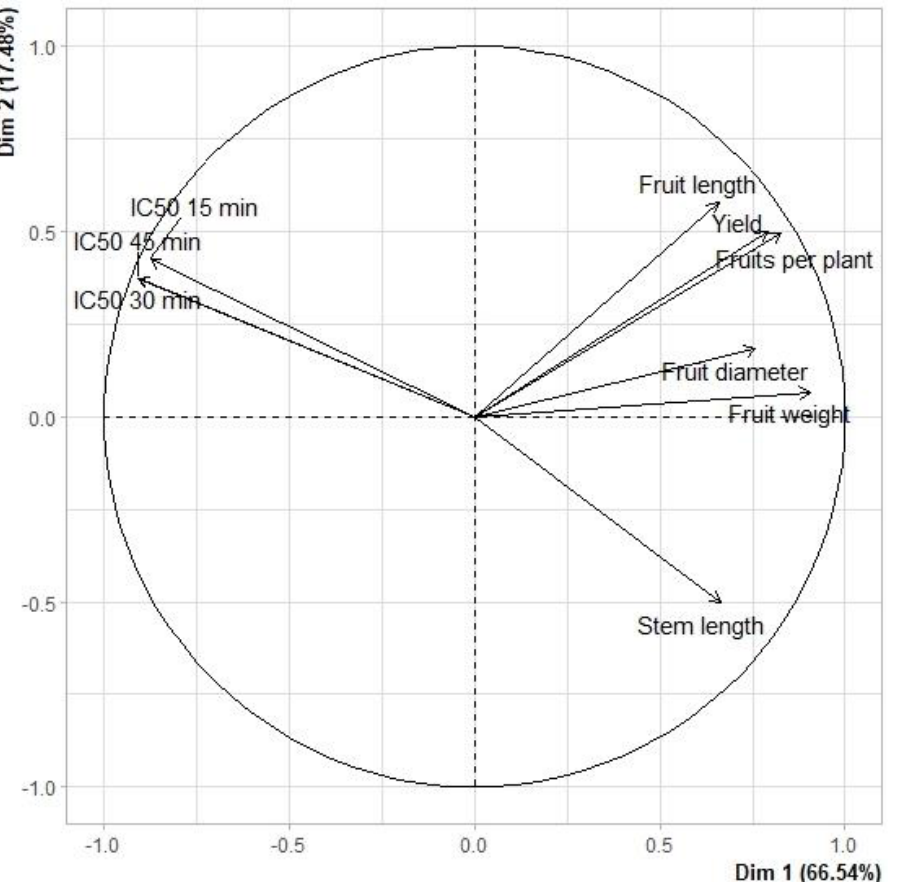
Figure 2. Loading plot of variables (yield, fruits per plant, fruit weight, fruit diameter, fruit length, stem length, IC 50 at 15 min, IC 50 at 30 min and IC 50 at 45 min) in the two-dimensional space (Dim 1 = PC 1 and Dim 2 = PC 2).